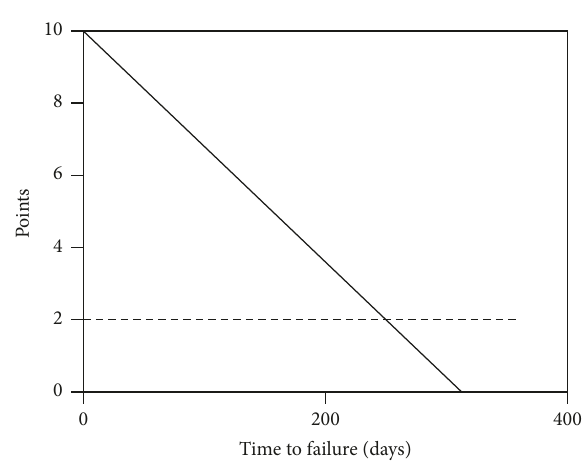
Figure 2: Deterioration model of unpaved roads.